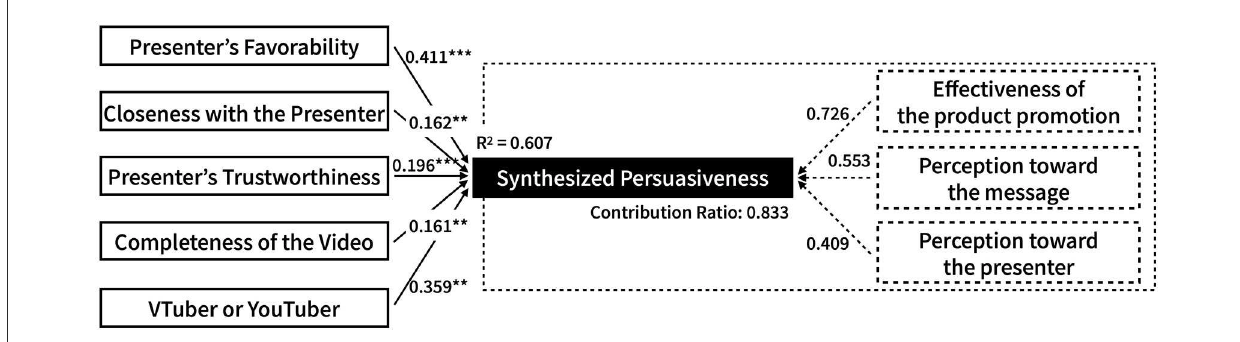
FIGURE5 Mechanisms of persuasiveness for YouTube product introduction videos (results of the multiple regression analysis). ** p < 0.01, *** p <